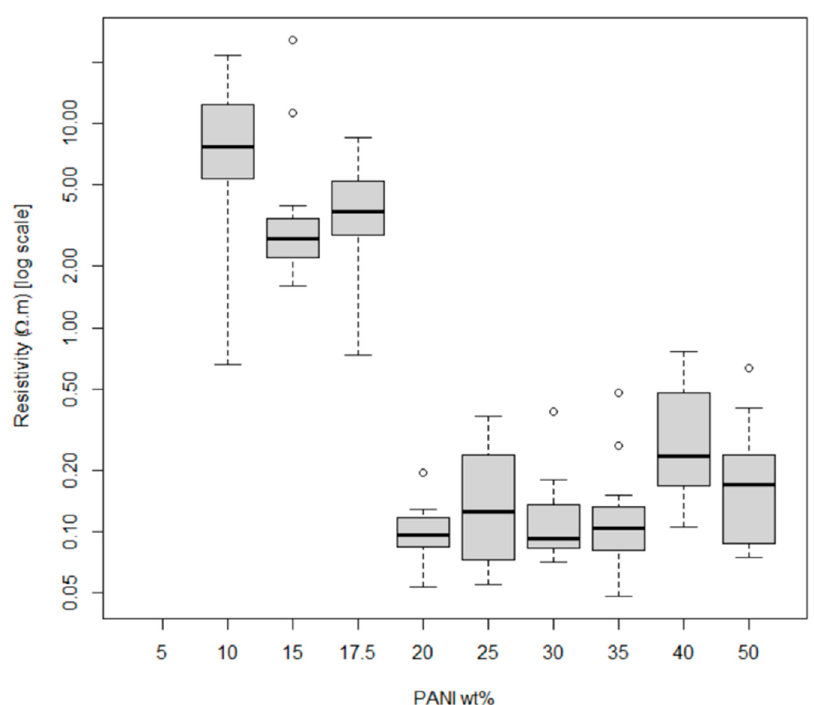
Figure 9. Average resistivity of 14 test lines printed at each wt% of PANI-EB + DBSA + Speedball composites shown in Table 1 (reproduced with permission from [23]). Circles show outlier data that fall outside the quartiles generated by the box plots using statistical software R .